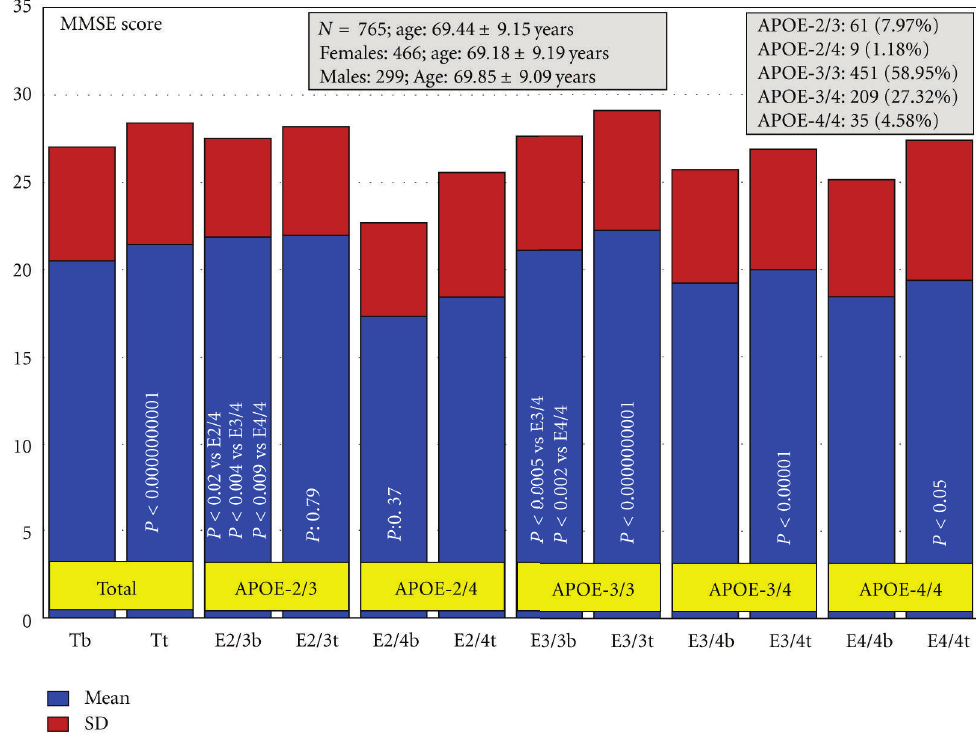
Figure 2: APOE -related therapeutic response to a multifactorial therapy in patients with dementia. Cognitive performance (MMSE Score). Tb: basal MMSE score prior to treatment; Tt: MMSE score after 3 months of treatment in the total sample. E2/3b: basal MMSE score in APOE-2/3 carriers; E2/3t: MMSE score after treatment in APOE-2/3 carriers; E2/4b: Basal MMSE score in APOE-2/4 carriers; E2/4t: MMSE score after treatment in APOE-2/4 carriers; E3/3b: basal MMSE score in APOE-3/3 carriers; E3/3t: MMSE score after treatment in APOE-3/3 carriers; E3/4b: basal MMSE score in APOE-3/4 carriers; E3/4t: MMSE score after treatment in APOE-3/4 carriers; E4/4b: basal MMSE score in APOE-4/4 carriers; E4/4: MMSE score after treatment in APOE-4/4 carriers.